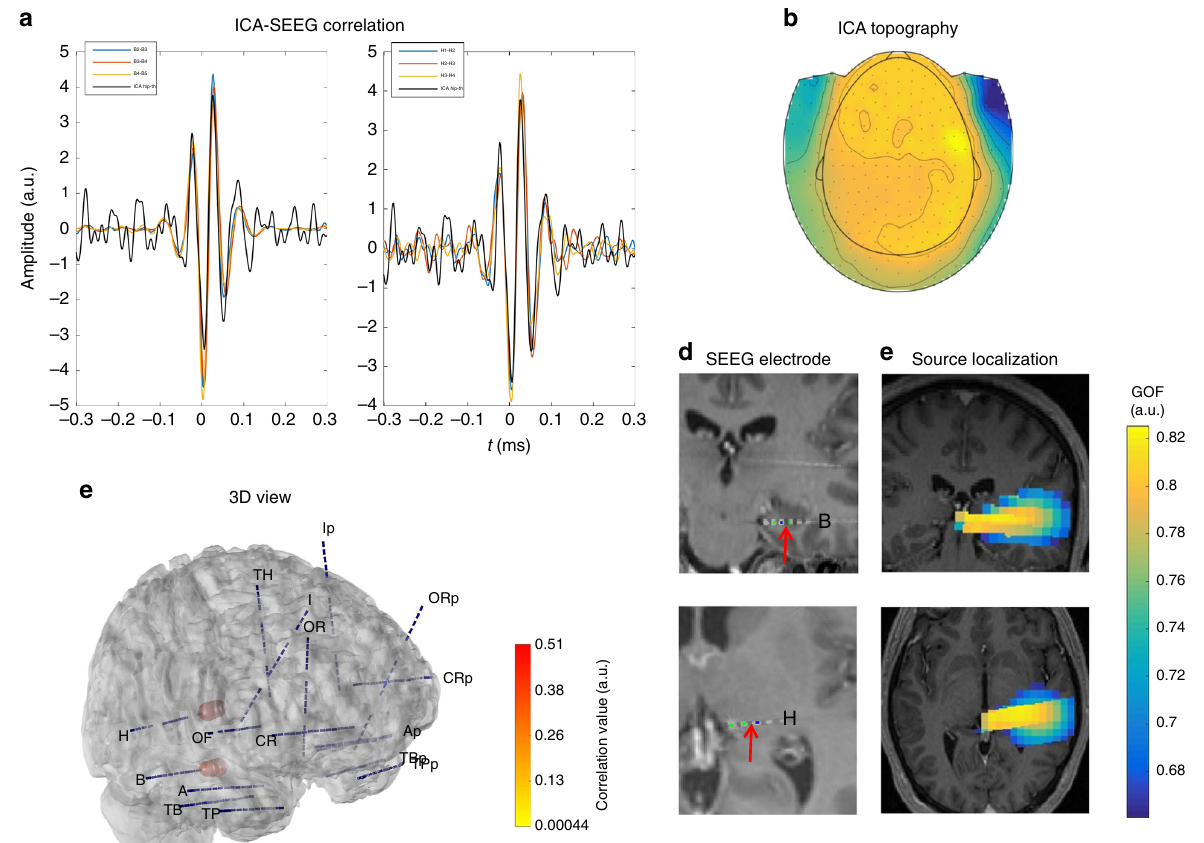
Fig. 2 Extended limbic network. ICA component correlated with thalamus and hippocampus in P8. a In black, ICA time course and in color, time courses on the SEEG contacts where signi fi cant correlation with ICA was measured. b MEG topography of ICA component. c 3D representation of MEG-SEEG correlation. Color (from yellow to red, refer to color bar) and sphere dimension correspond to the correlation value. d MRI (T1) with reconstructed SEEG electrodes; the arrow indicates the contact with the highest correlation value, located in the right hippocampus (B) and right thalamus (H). e Source localization (single dipole) of the ICA component overlaid on patient MRI, which includes regions sampled by mesial contacts of electrodes B and